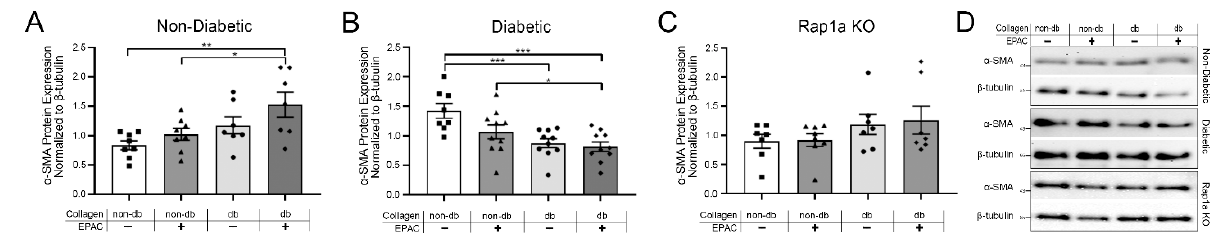
Figure 4. Endogenous AGEs and Rap1a activation altered α -SMA protein expression in both non- diabetic and diabetic fibroblasts. Cardiac fibroblasts were isolated and cultured on non-diabetic or diabetic collagen as well as treated with EPAC (100 µ M). Changes in α -SMA (42 kDa) protein expression in ( A ) non-diabetic, ( B ) diabetic, and ( C ) Rap1a KO cardiac fibroblasts were assessed. ( D ) Representative Western blot images for α -SMA expression. α -SMA protein expression was normalized to β -tubulin (55 kDa). Mean ± SEM are presented in graphs with an n = 6–10. Statistical analysis consisted of one-way ANOVA followed by a Fisher’s Protected Least Significant Difference post hoc (* p < 0.05, ** p < 0.01, and *** p <